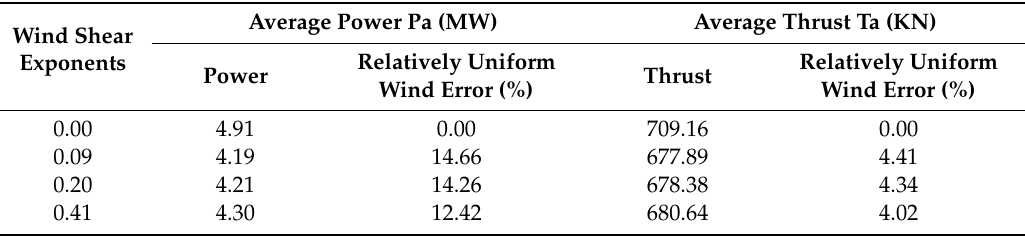
Table 9. The power for various wind shear exponents ( γ ) at V hub = 11.4 m / s ( I ref = 0.14, tilt angle = 4 ◦ ). Wind Shear